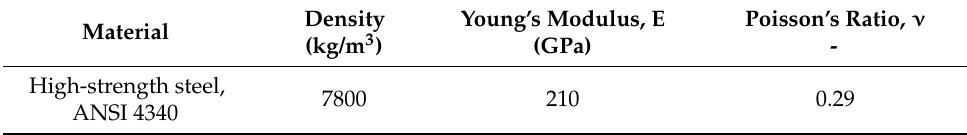
Table 2. Material property of high-strength steel according to ANSI 4340.